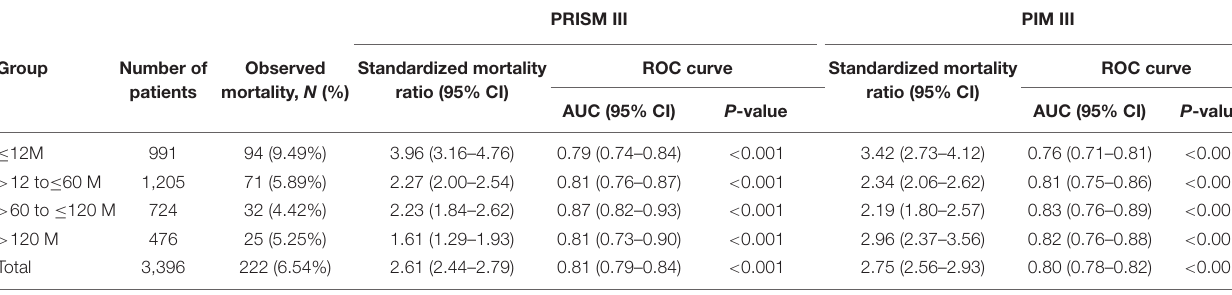
TABLE 5 | Performance per age group.